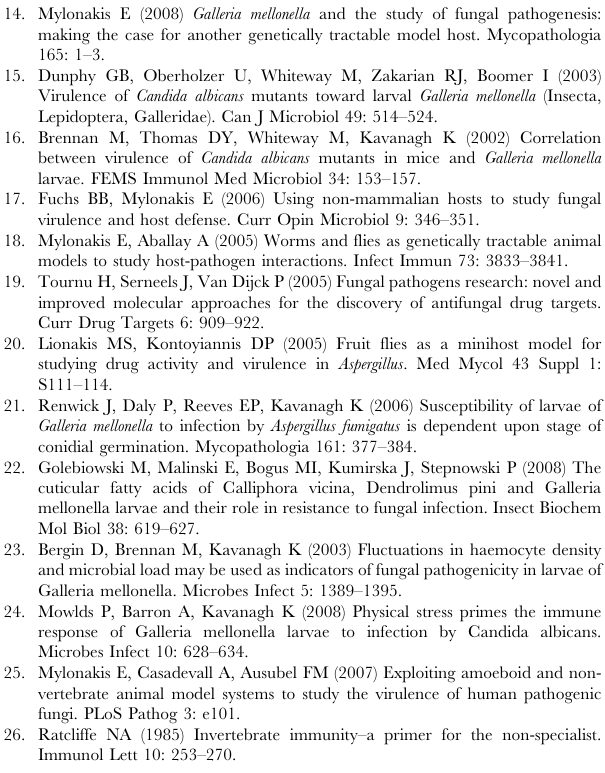
Figure S2 A. fumigatus hyphae isolated from G. mellonella haemolymph. Larvae were infected with A. fumigatus B5233 wild type strain. Haemolymph was collected after 24 hours post inoculation and was immediately examined microscopically. Scale